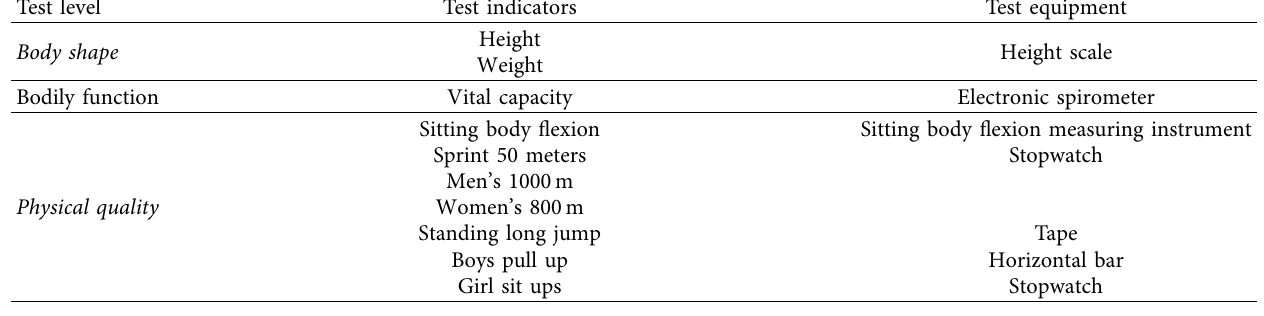
Table 3: Measurement indicators and equipment.